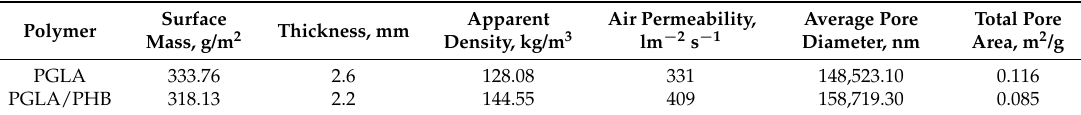
Table 2. Characteristics of the needle-punched non-woven fabrics used for macroporous layer of bone implants for osseous tissue regeneration.